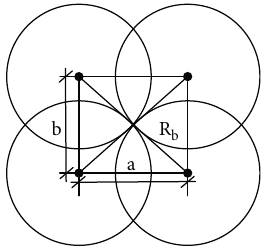
Figure 7: Schematic diagram of adjacent grouting holes.